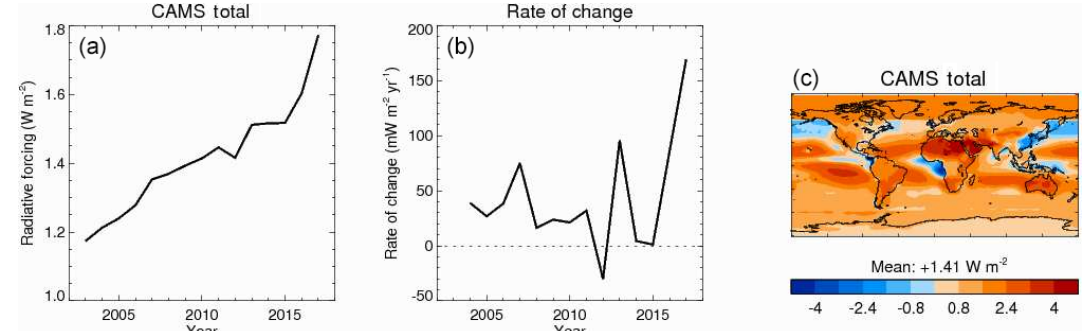
Figure 12. (a) Time series of global annually averaged total stratospherically adjusted radiative forcing in the shortwave and longwave spectra (Wm − 2 ) for the period 2003–2017. Total radiative forcing is defined here as the sum of the radiative-forcing components shown in Fig. 10. (b) Rate of change in total radiative forcing, calculated as the change in total radiative forcing from a given year to the next (in mWm − 2 yr − 1 ). (c) Distribution of total stratospherically adjusted radiative forcing, averaged over the period 2003–2017 (in Wm − 2